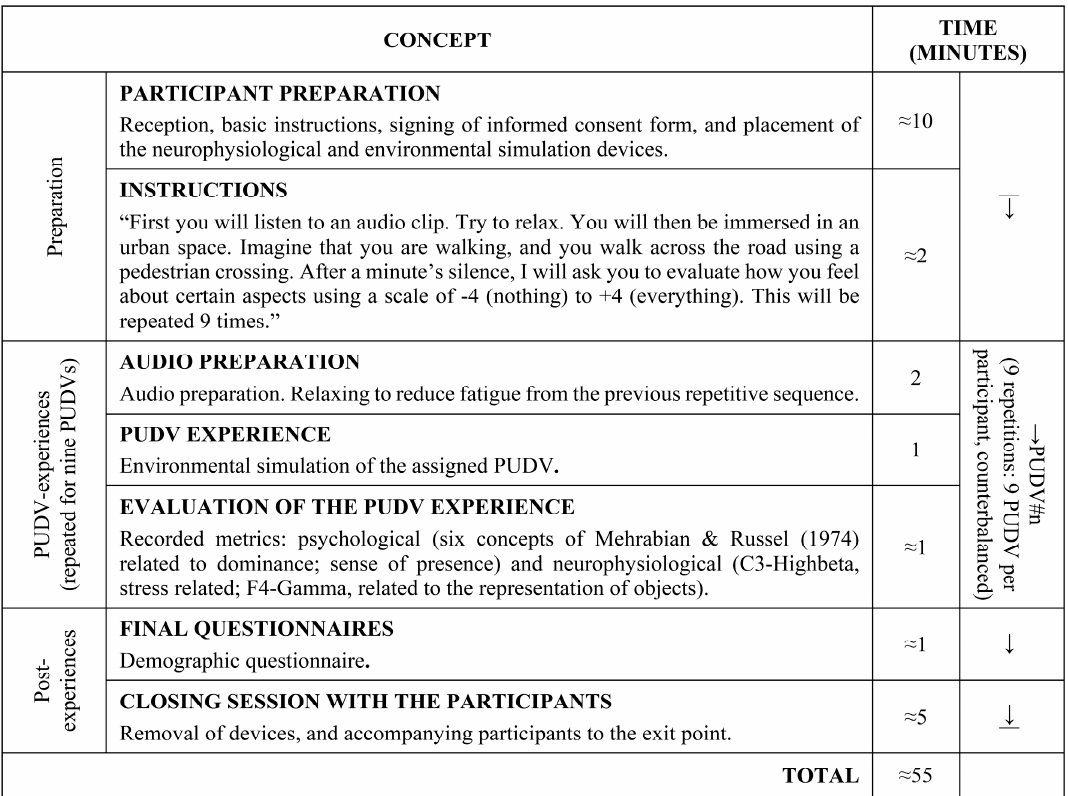
Figure 1. General testing sequence.